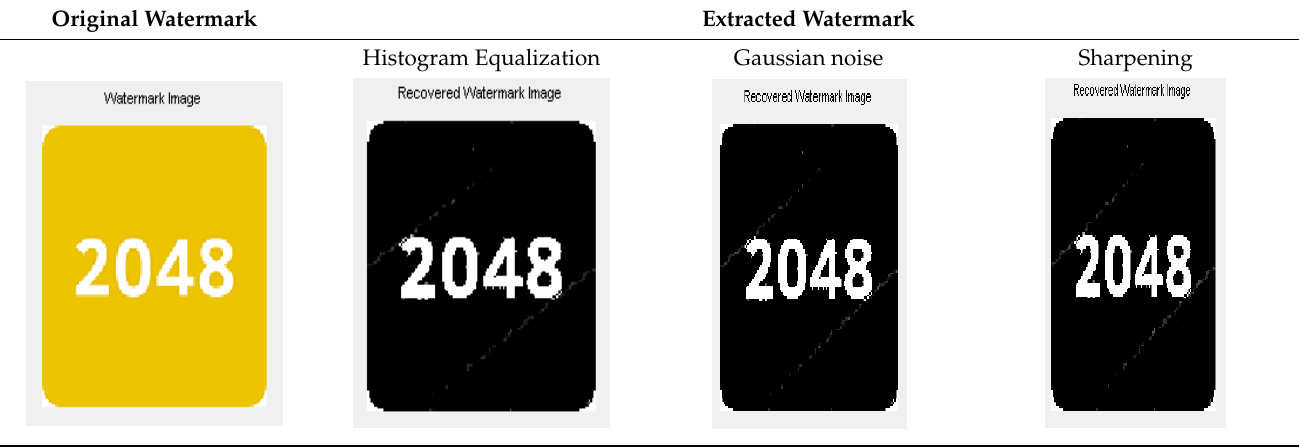
Figure 17. Sharpened watermarked image and extraction after sharpening of the watermarked image.